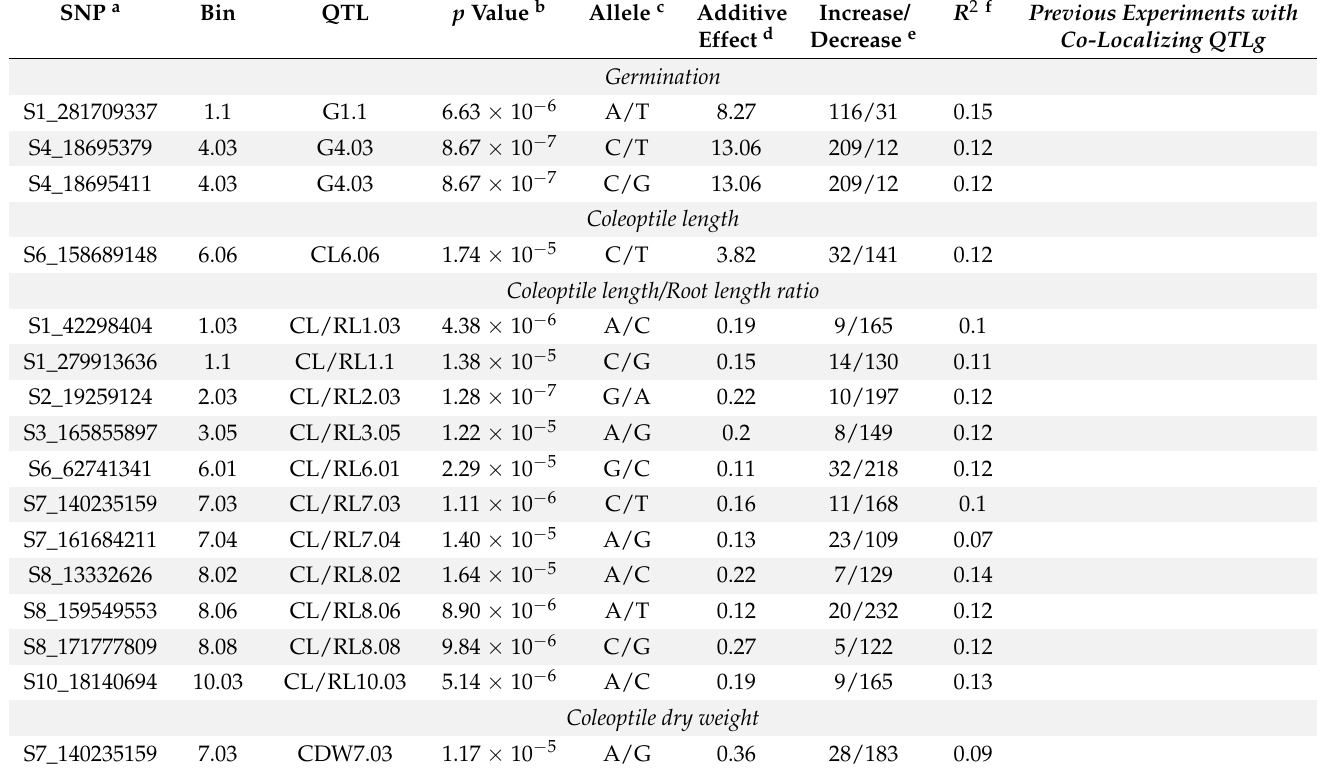
Table 4. SNPs significantly associated with germination and seedling establishment-related traits under well-watered conditions. Chromosome position (bin), the number of QTLs, the significance of the association, the number of RILs with favorable and unfavorable alleles, the additive value, and the variance explained by each SNP are included in the table. SNP a